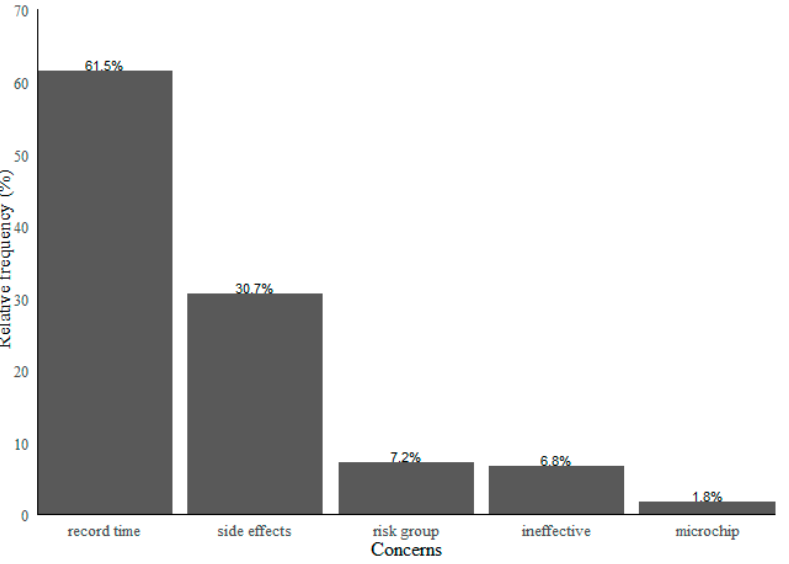
Figure 2. Major reported concerns relative to the COVID-19